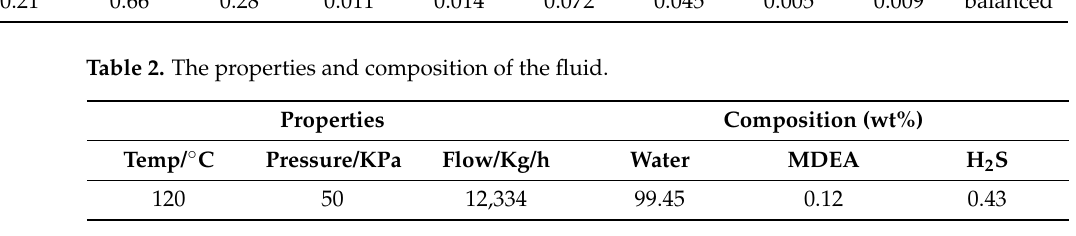
Table 2. The properties and composition of the fluid.